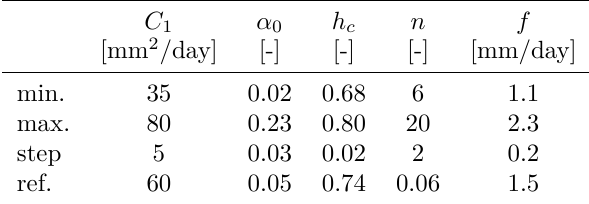
Parameters of the transport problem: ranges, stepping for identification and the reference set.